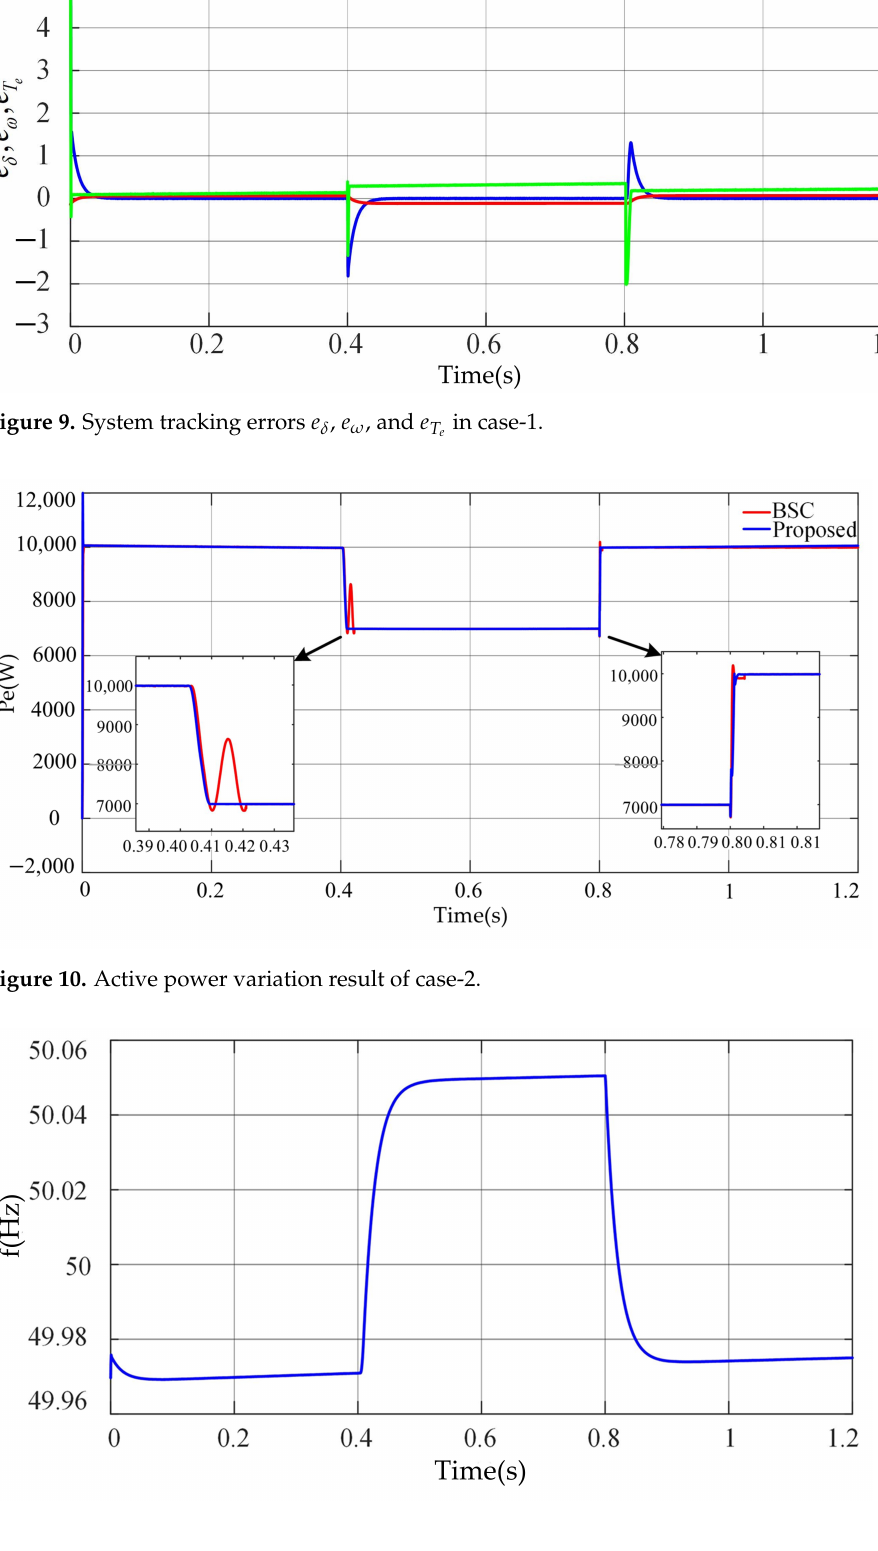
Figure 11. Frequency variation result of